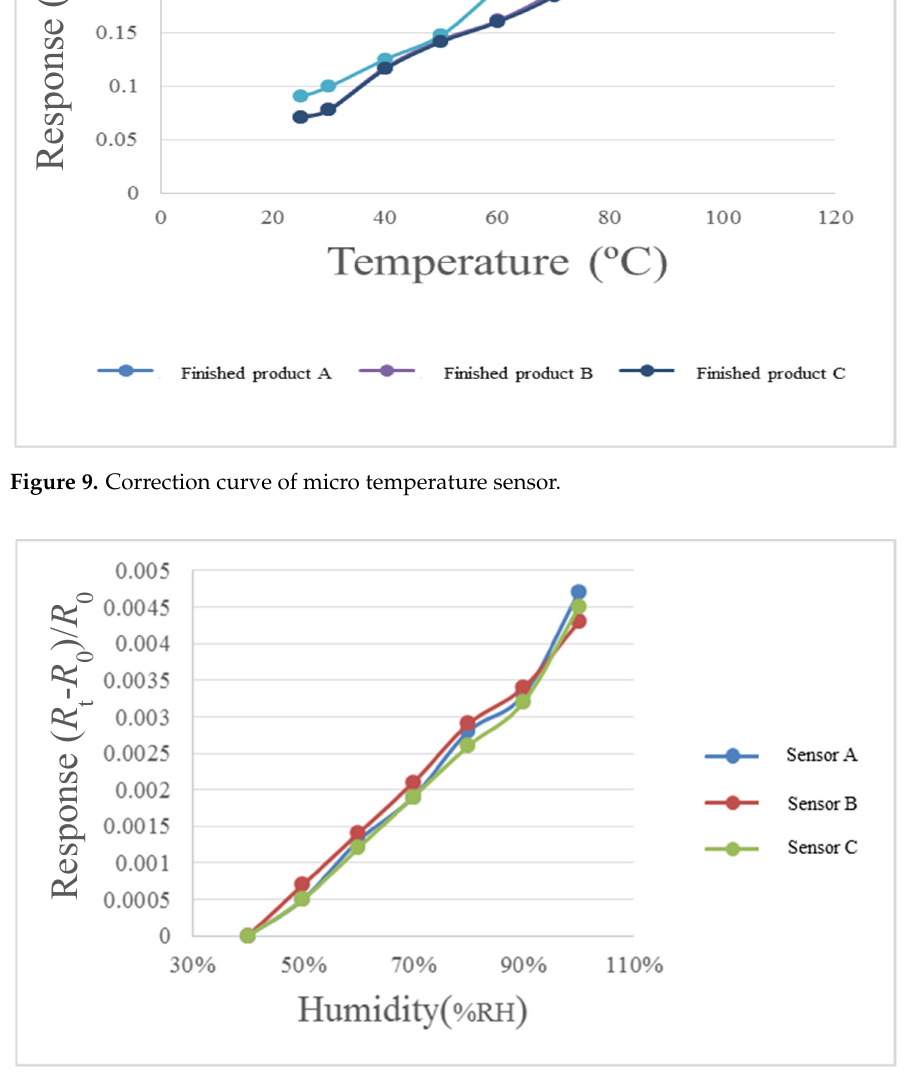
Figure 10. 30 °C relative humidity correction curve diagram. Figure 10. 30 ◦ C relative humidity correction curve